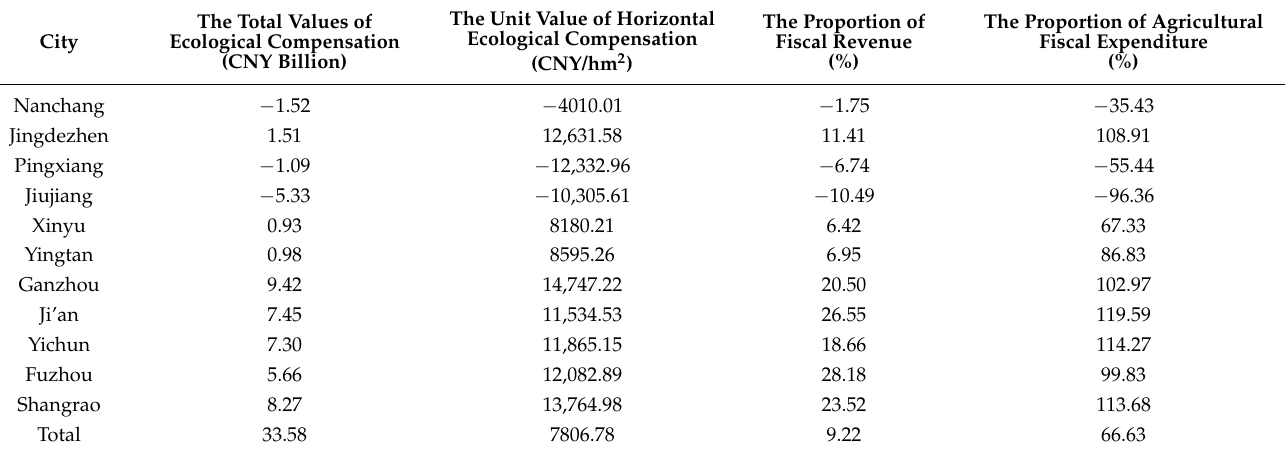
Table 5. The rationality analysis of ecological compensation values in Jiangxi